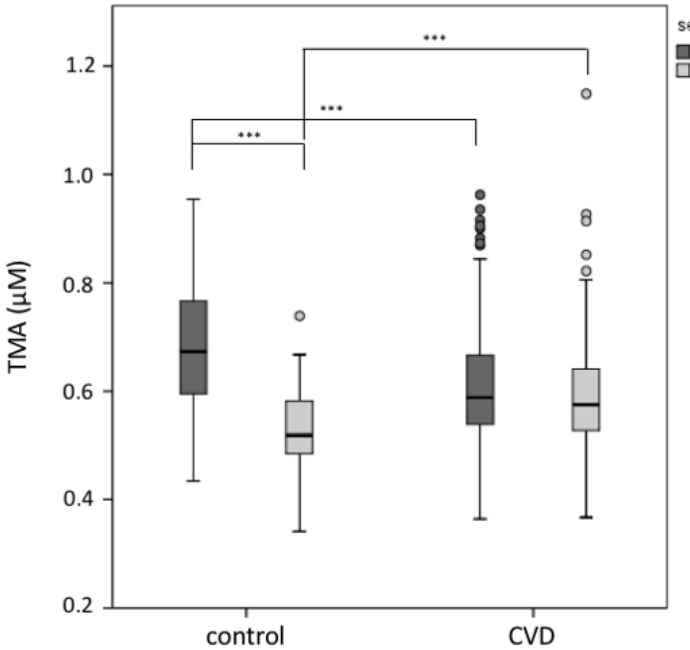
Figure 1. Plasma TMA level in males and females. The male control group displays higher plasma TMA levels compared to female controls. Male CVD patients show a lower TMA value with respect to healthy controls of the same gender, while an opposite result was observed in the female groups. Male controls ( n = 89) and male CVD patients ( n = 269). Female controls ( n = 64) and female CVD patients ( n = 125), *** p <